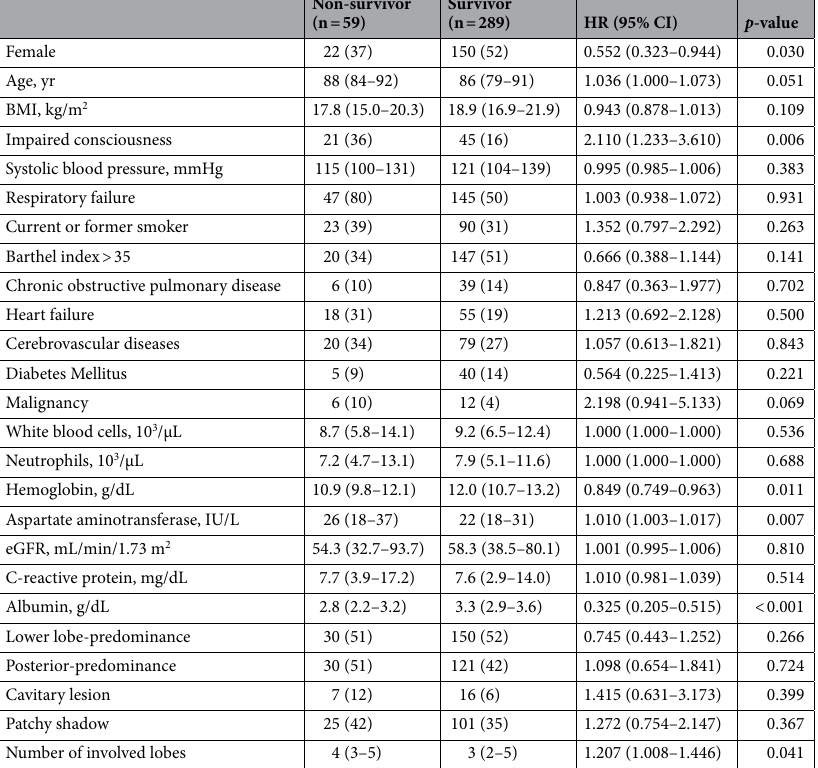
Table 5. Univariate Cox hazard regression analysis of the baseline characteristics and radiological features associated with in-hospital mortality. Data are presented as the number (%) or median (interquartile range). BMI, body mass index; CI, confidence interval; eGFR, estimated glomerular filtration rate; HR, hazard ratio.